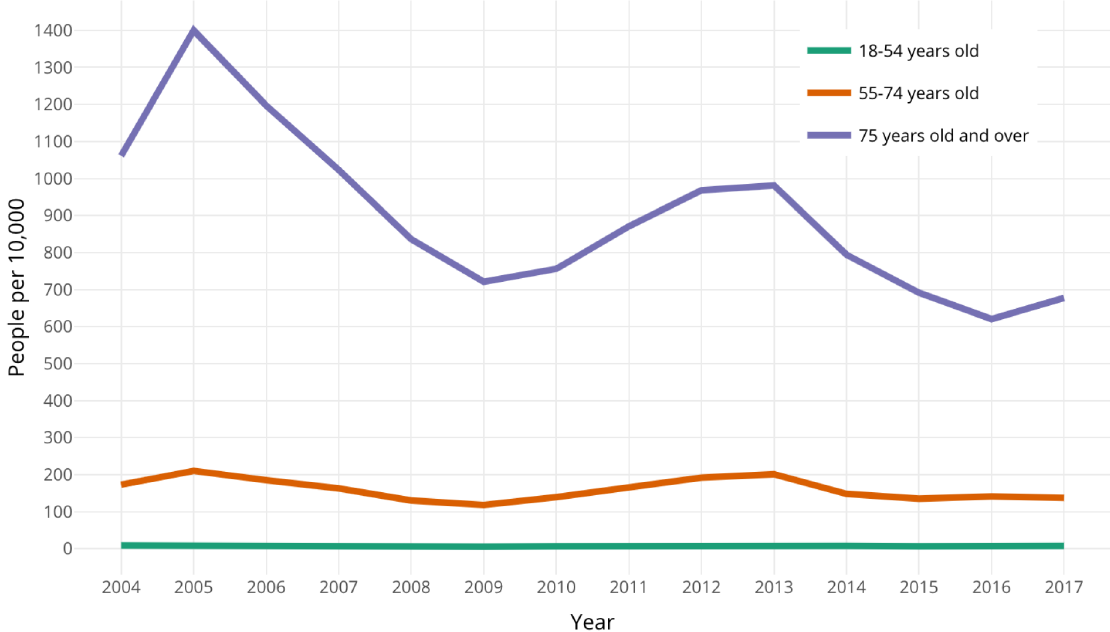
Figure 1: Incidence of CKD in Tasmania according to different age